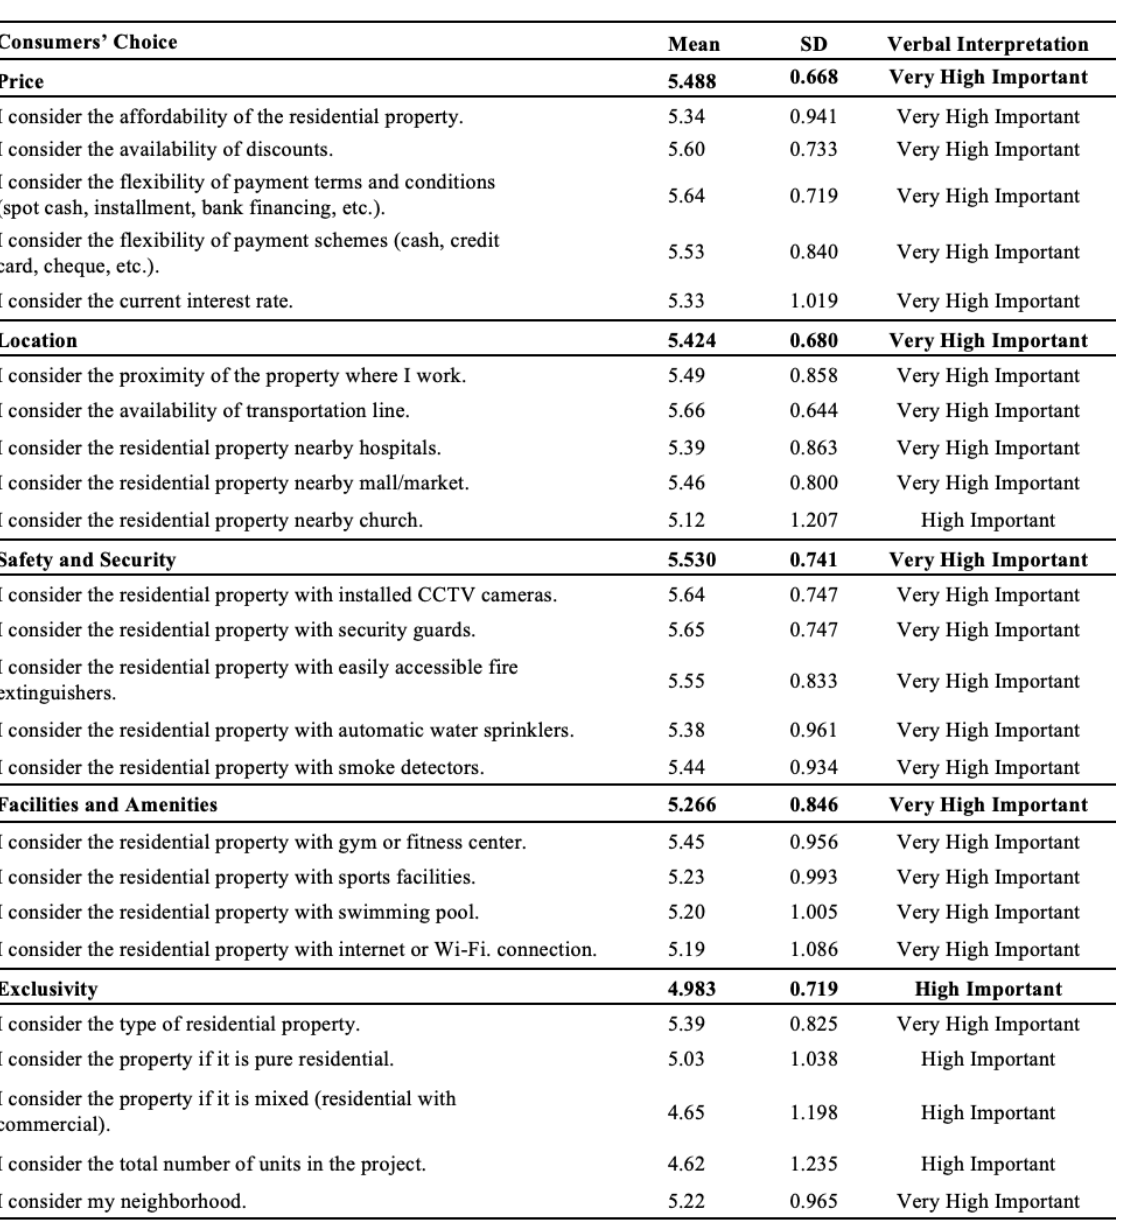
Table 3: Level of Importance of the Consumers' Choice